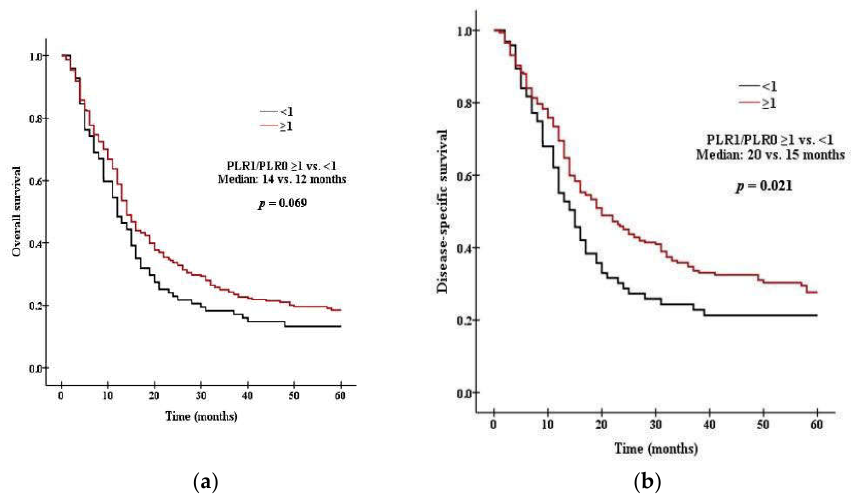
Figure 3. Kaplan–Meier curves of ( a ) OS in patients with PLR1/PLR0 ≥1 versus PLR1/PLR0 < 1, ( b ) DSS in patients with PLR1/PLR0 ≥ 1 versus PLR1/PLR0 < 1.